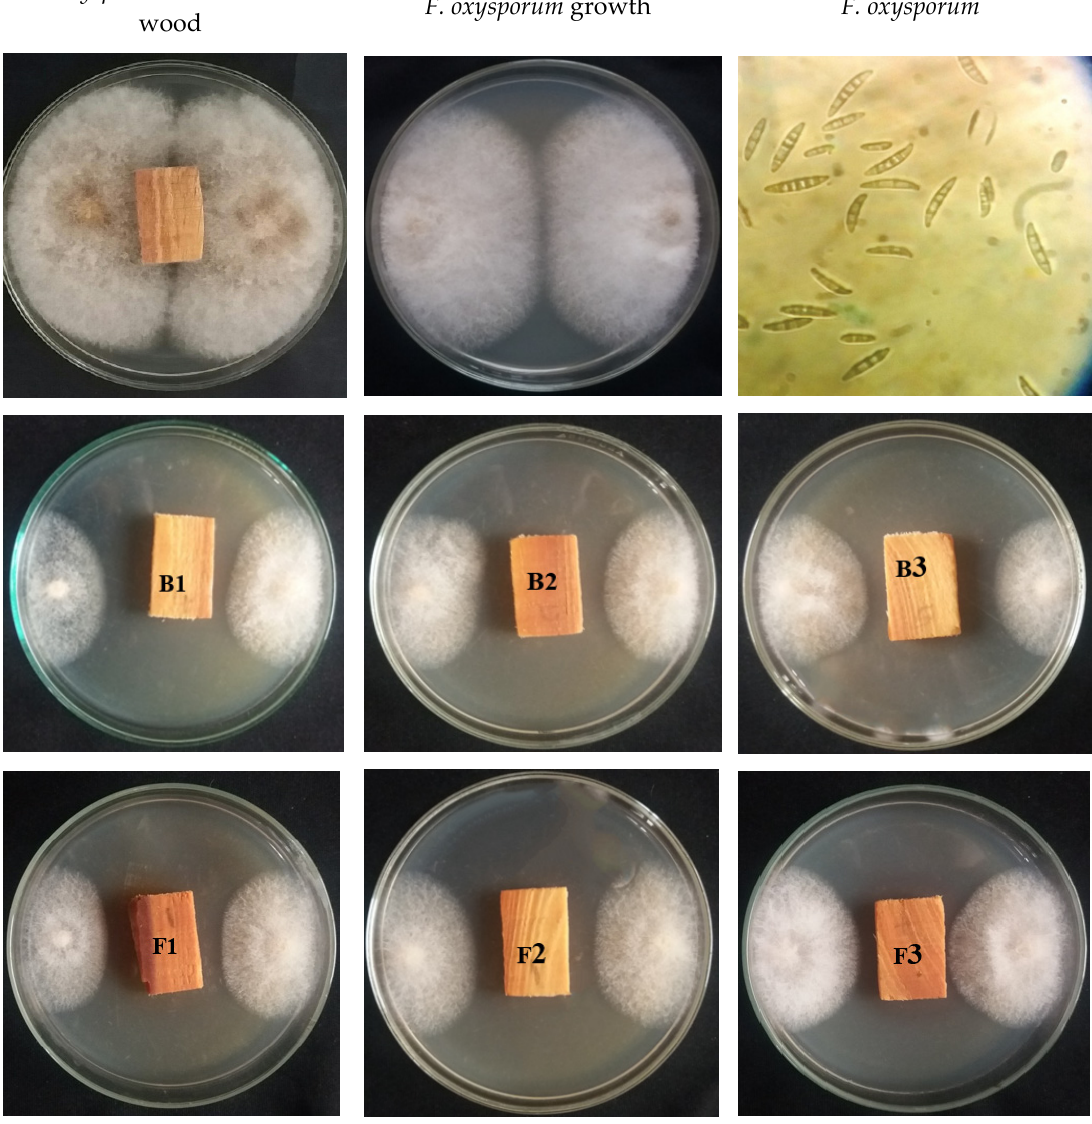
Figure 2. Antifungal bioassay of wood treated with (B) P. halepensis OLE and (F) S. terebinthifolius EO against the growth of F. oxysporum . B1: 3%; B2: 2%; B3: 1%; F1: 3%; F2: 2%; F3: